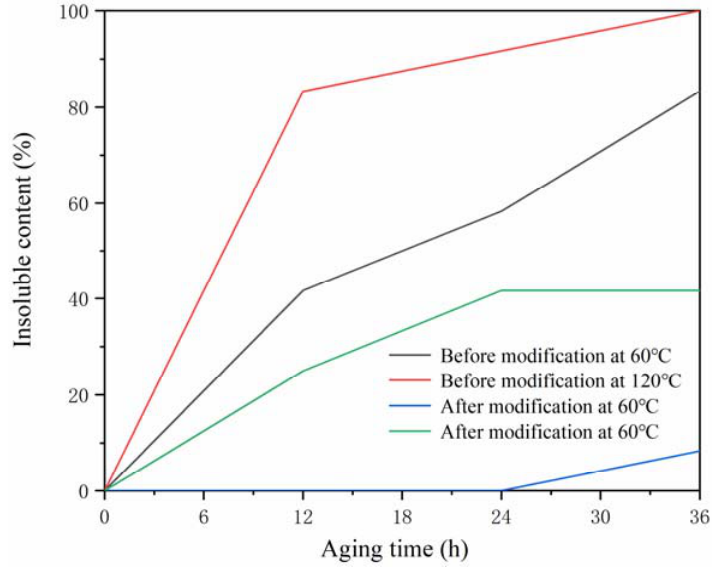
Figure 2. Changes in the insoluble matter content of shellac in ethanol solution before and after modification.